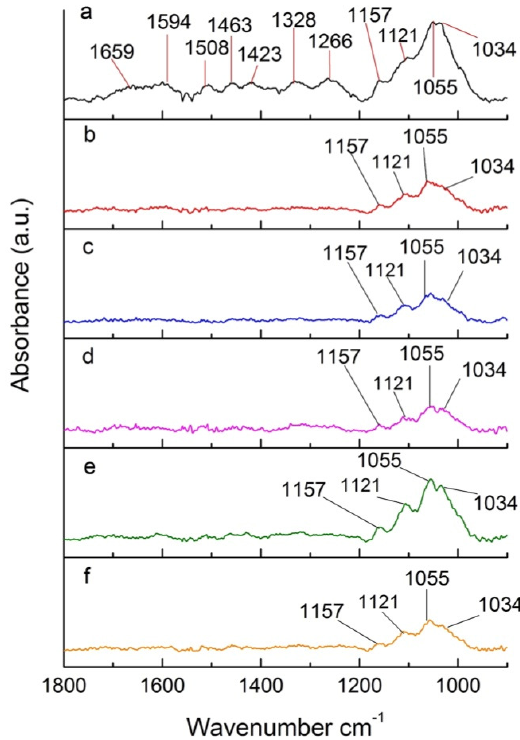
Figure 8. Section of FTIR spectra of ( a ) untreated poplar and ( b – f ) poplar treated at reduced pres- sures.